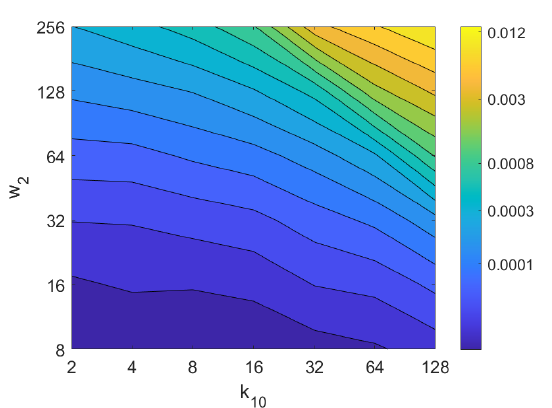
Figure 43. BG orientation estimation. Average computation time